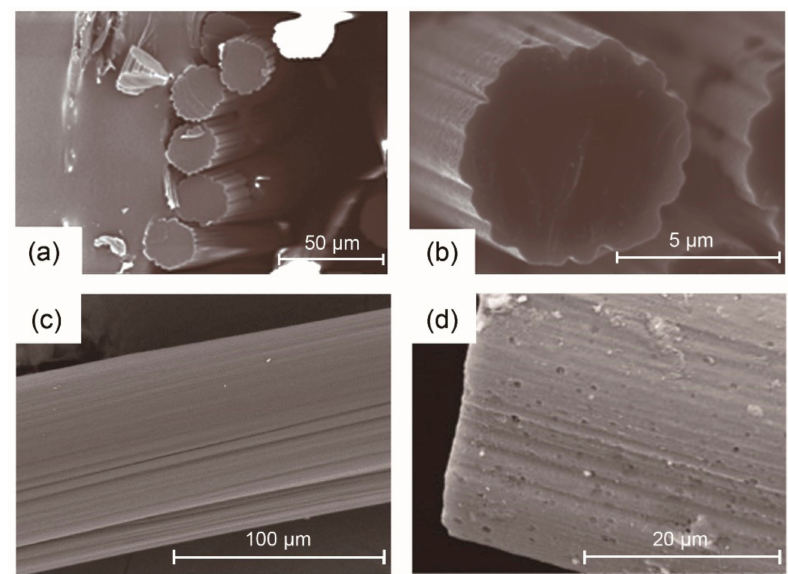
Figure 8. SEM images of ( a ) acetylated softwood Kraft lignin as-spun fibers and ( b ) corresponding carbon fibers by dry-spinning; ( c ) lignin/PVA (70/30) fiber and ( d ) corresponding lignin/PVA porous carbon fiber by wet spinning. ( a , b ) Reproduced with permission from [31], copyright 2014 Elsevier. ( c , d ) Reproduced with permission from [138], copyright 2019 John Wiley and